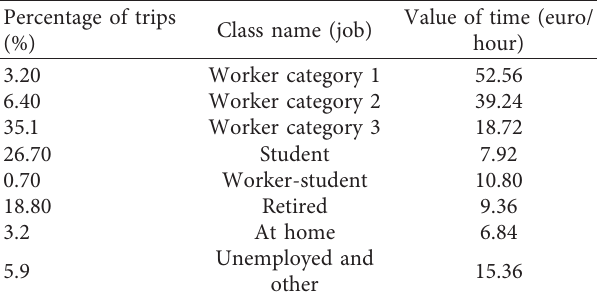
Table 2: User classes and their value of time for the Lyon 6th+Villeurbanne